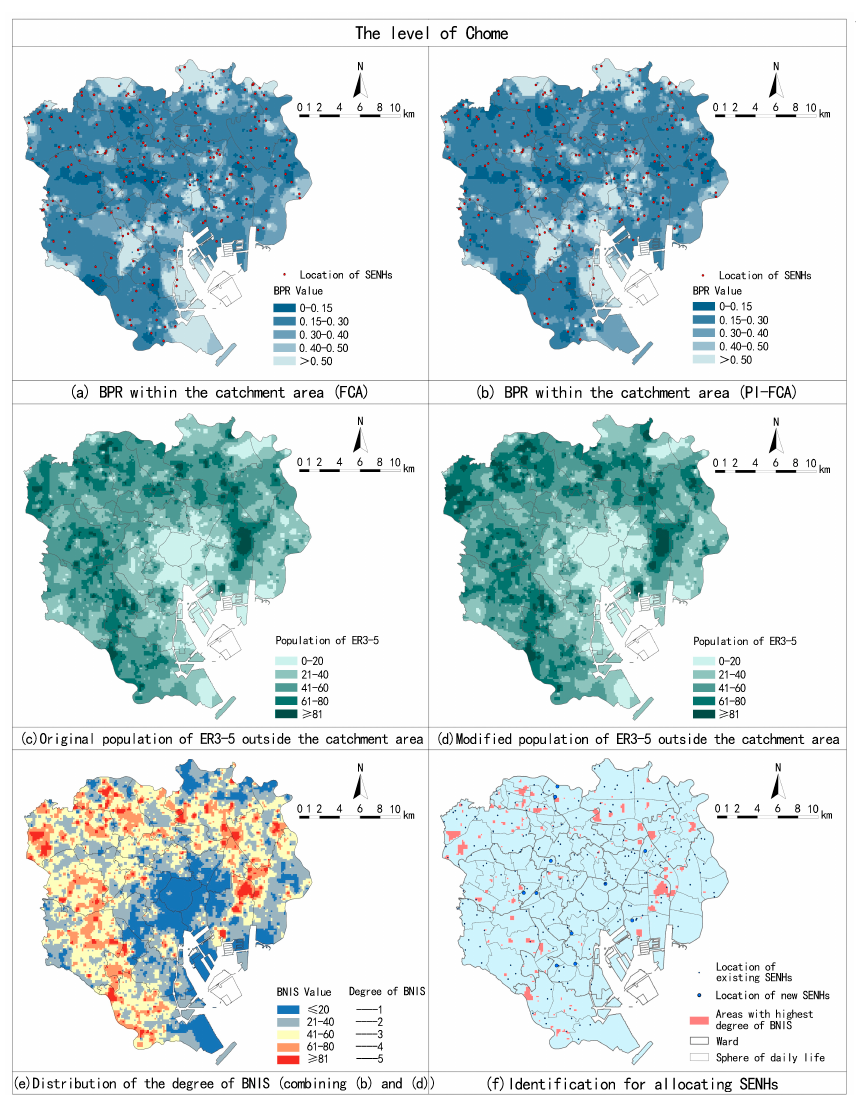
Figure 6. Estimates by the FCA and PI-FCA ( a , b ), population of the ER3-5 before and after applying C pd ( c , d ), distribution of the degree of BNIS, and identification for allocating SENHs ( e , f ). Int. J. Environ. Res. Public Health 2017 , 14 , 1102